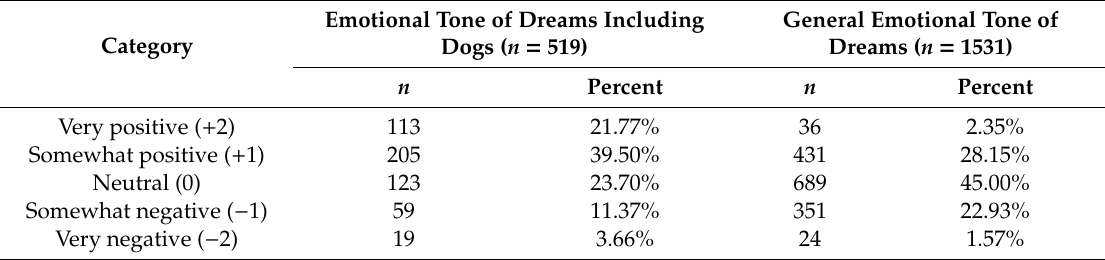
Table 2. Emotional tone of dreams that include dogs and the general emotional tone of dreams.